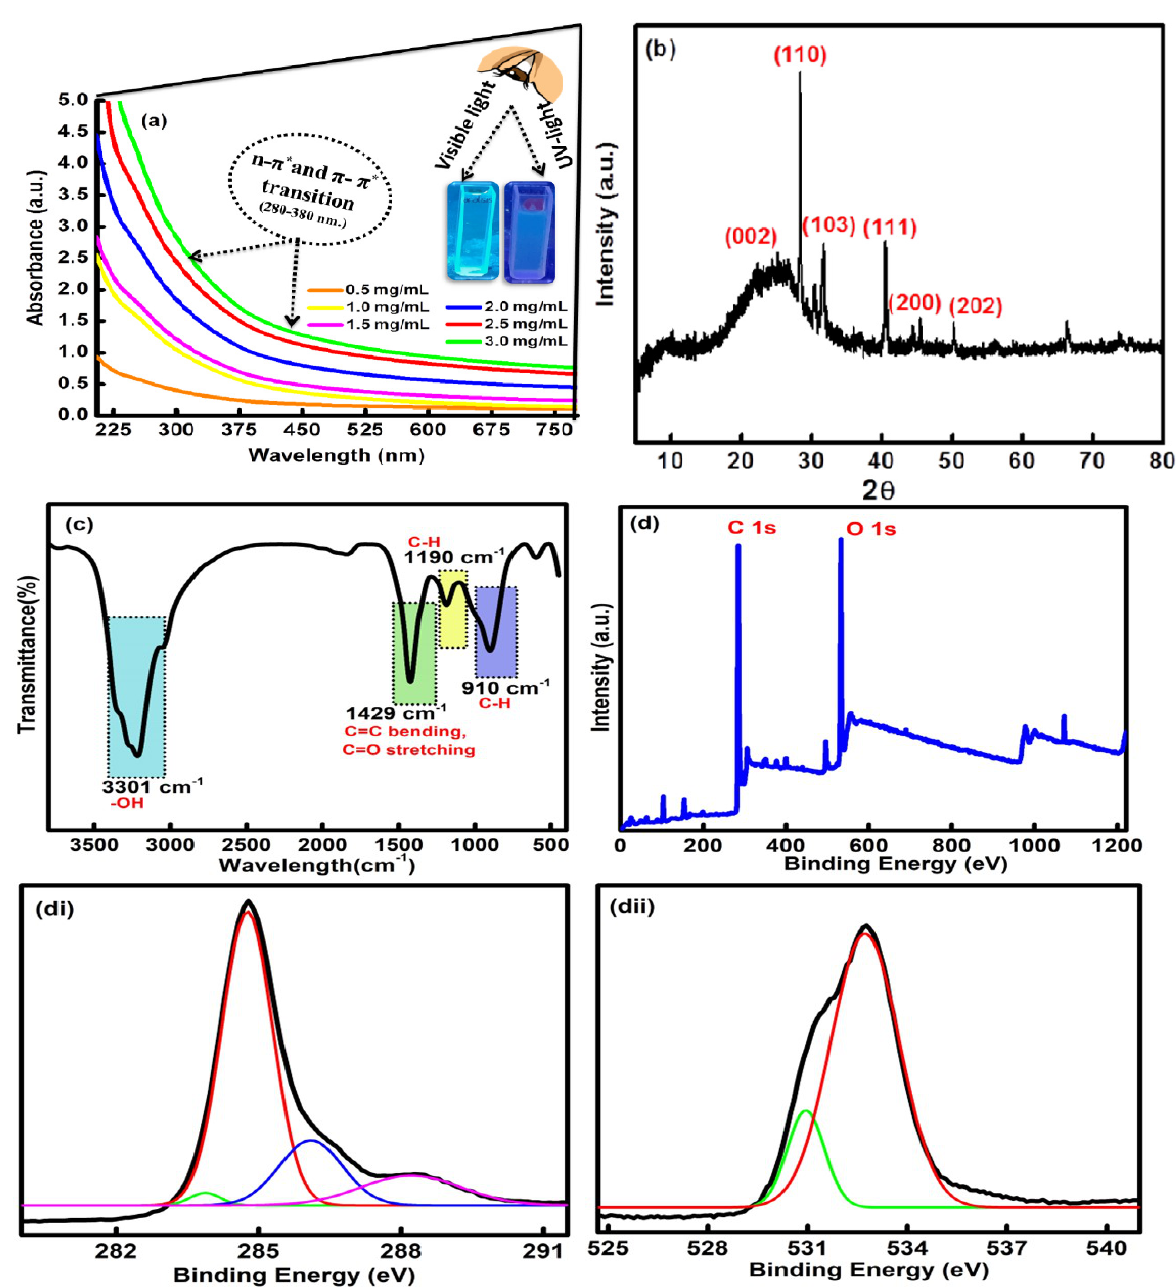
Figure 2. ( a ) Concentration-dependent UV-vis absorbance, ( b ) XRD, ( c ) FTIR and ( d – dii ) XPS survey scan of CQDs.